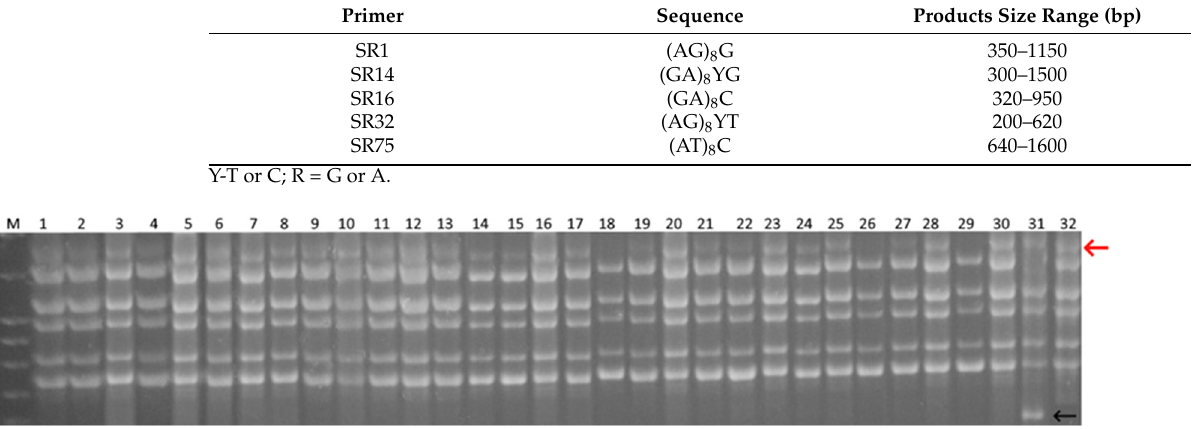
Figure 4. PCR products of SR75 primer. Description of lanes: M—marker, 1–30 regenerated